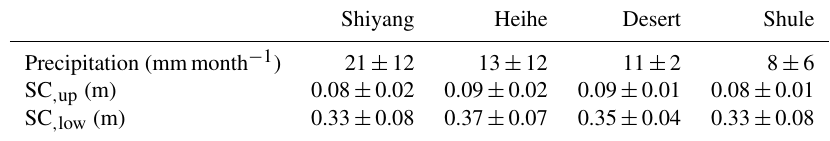
Table 3. Averaged values and standard deviations of precipitation and model parameters for four different basins.